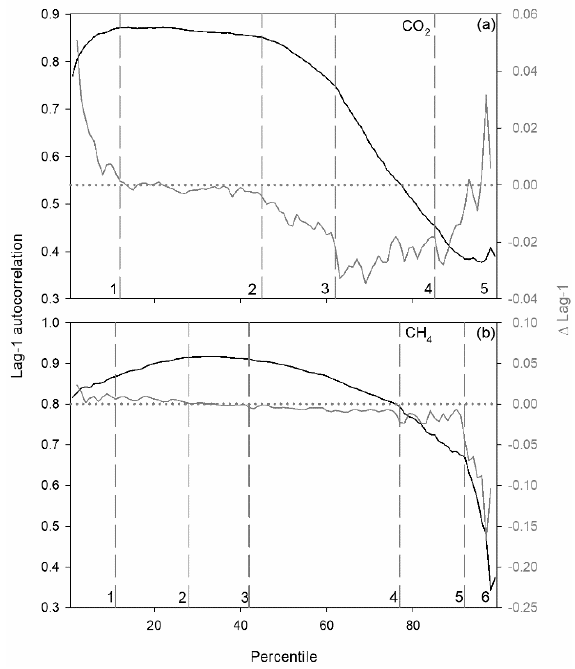
Figure 7. Groups of percentiles following the lag- 1 autocorrelation and Δ lag -1. ( a ) CO 2 , ( b ) CH 4 .